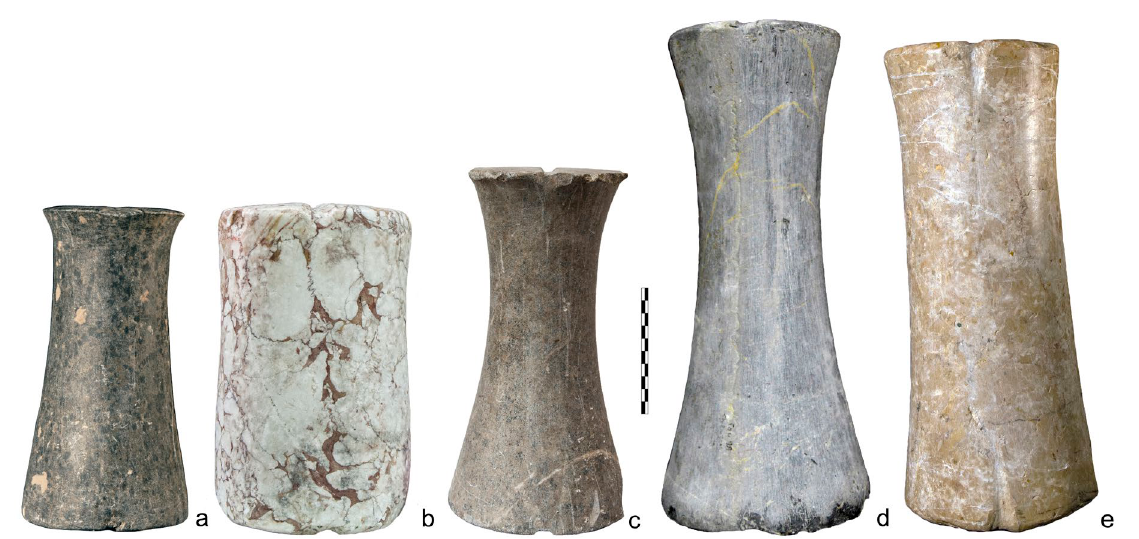
Figure 5. The main types of miniature columns from Gonur Depe (a, d. from the depositories of the National Museum of Turkmenistan, Ashgabat; b, c. from the depositories of the Local history museum of Mary province, Mary): а. truncated -conical with a hat; b. cylindrical; c. biconical with a hat; d. biconical; e. biconical slightly profiled. Scale bar is 10 cm long, separated into 1 cm segments.